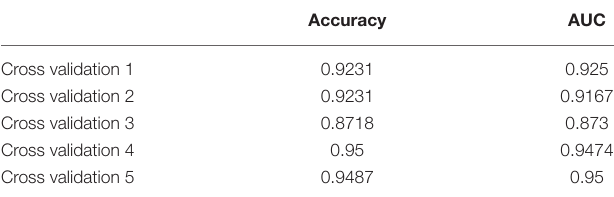
TABLE 2 | Five-fold cross-validation